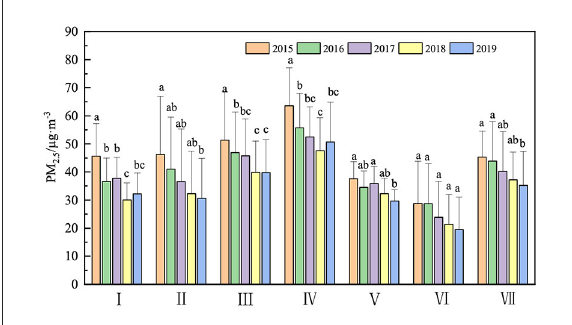
FIGURE1 Variation characteristics of PM 2.5 in different regions from 2015 to 2019 (I) Northeast China, (II) North China, (III) East China, (IV) Central China, (V) South China, (VI) Southwest China, and (VII) Northwest China (Letters denote the result of One-way